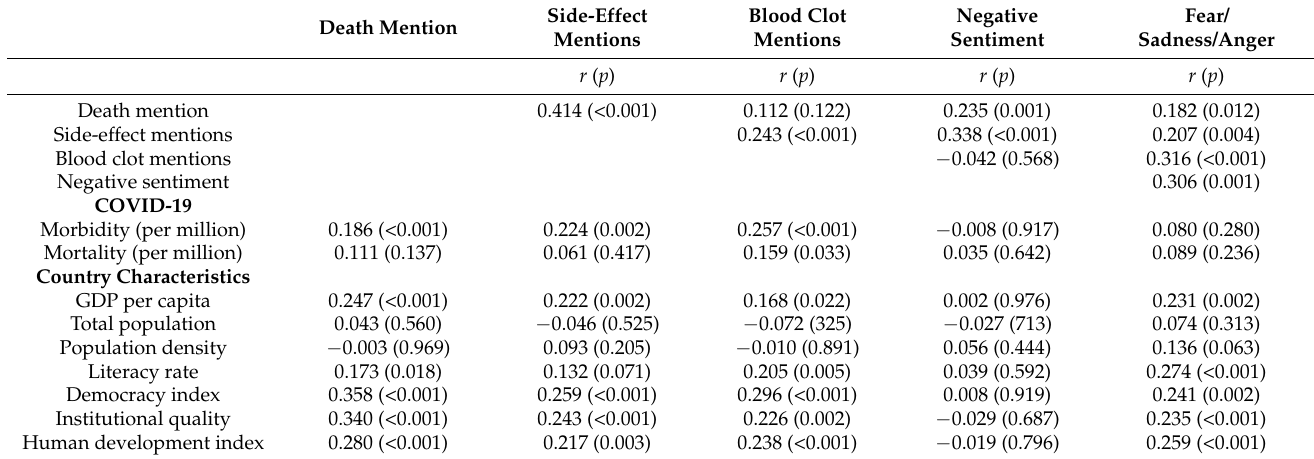
Table 3. Correlations among adverse mentions, negative sentiment, and